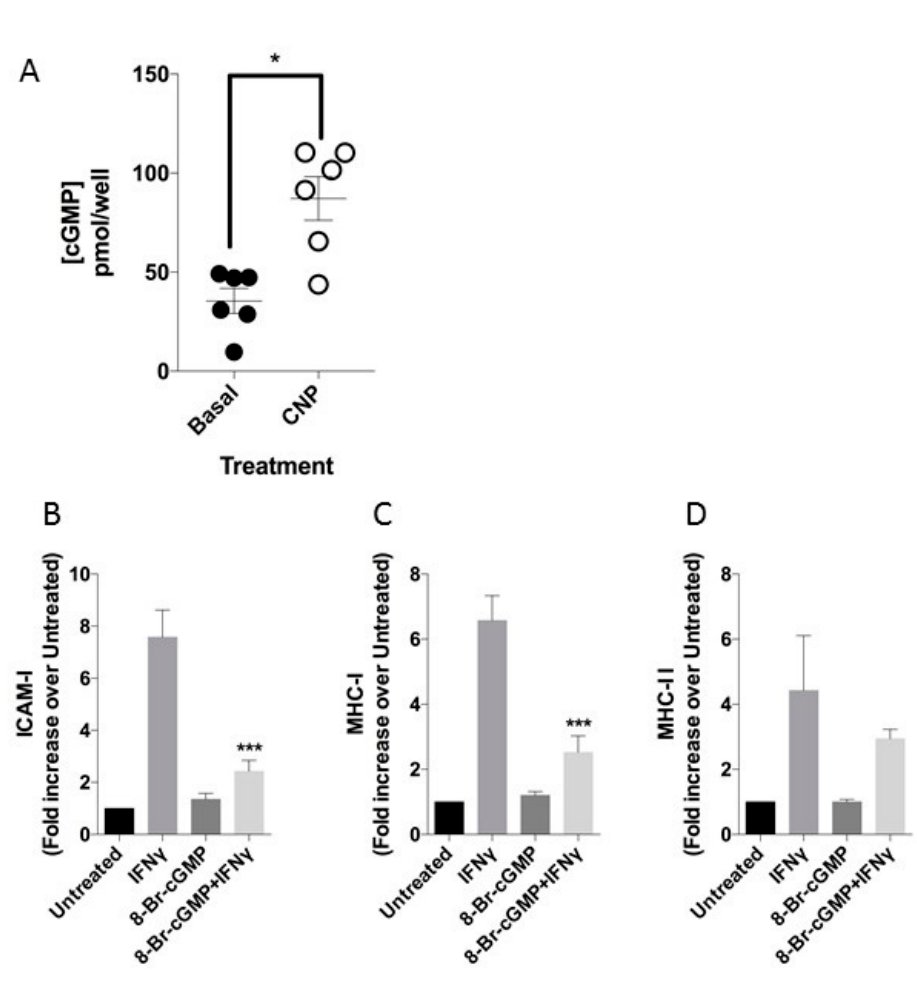
Figure 4. cGMP mediated effects on cell surface receptor expression in HUVEC. ( A ) CNP-stimulated cGMP accumulation in HUVEC isolates, after 30 min stimulation with 100 nm CNP in the presence of 1 mm IBMX. Data shown are means ± SEM pooled from 6 independent isolates ( n = 6), each performed in duplicate (* p = 0.015, significantly different from Basal). ( B – D ) Effect of 8-bromo-cGMP on IFN- γ mediated ICAM-1 ( B ), MHC-I ( C ), and MHC-II ( D ) expressed as fold increase over MFI of untreated cells expression after 48hr treatment (which ranged from 572 to 819, 1313 to 2012, 176 to 230, for ICAM-1, MHC-I and MHC-II, respectively). n = 3 HUVEC isolates (* p < 0.05, *** p < 0.001, significantly different from IFN- γ